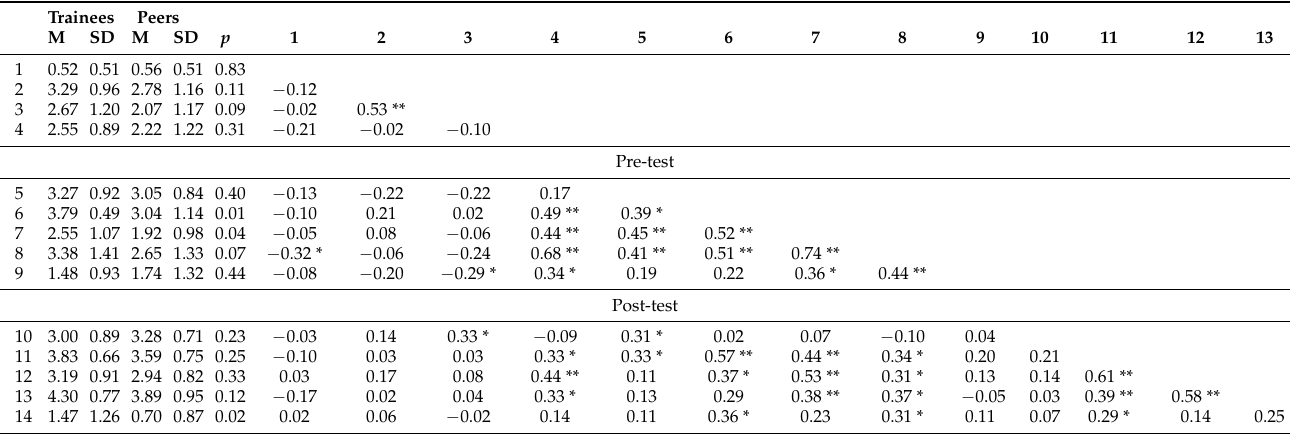
Table 1. Means, standard deviations, and correlations of variables at pre-test and